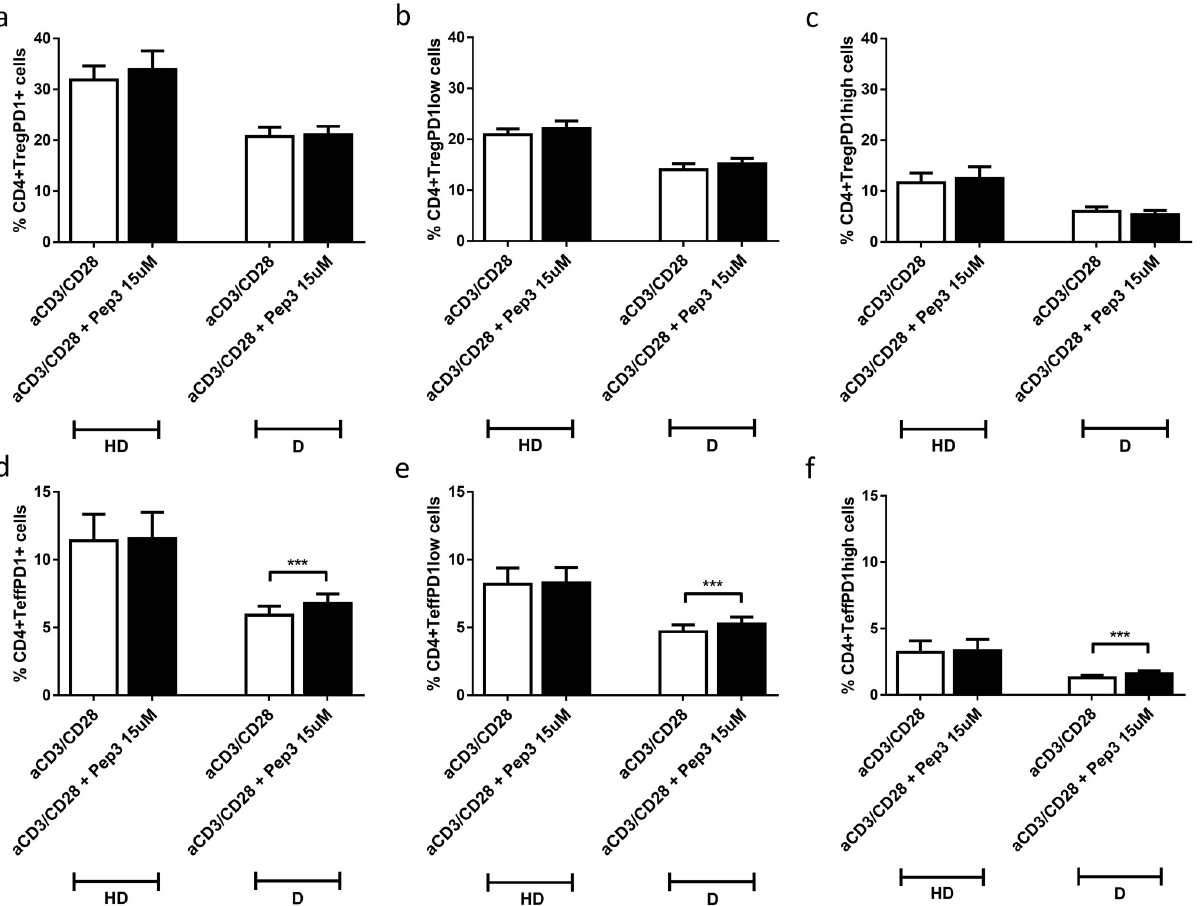
Fig 6. Frequency of CD4+PD1+ cell populations relative to HD and type 1 diabetes upon treatment with peptide 3 and subsequent stimulation with anti-CD3/CD28 beads for 4 days. Flow-cytometry analysis of HD and type 1 diabetes PBMC following 15 μ M of Pep3 treatment and subsequent stimulation for four days with anti-CD3/CD28 beads. Graphs show the percentage of CD4+ Treg PD1+ cells ( a ), CD4+ Treg PD1low cells ( b ), CD4+ Treg PD1high cells ( c ), CD4+ Teff PD-1+ cells ( d ), CD4+ Teff PD-1low cells ( e ), CD4+ Teff PD-1high cells ( f ). Percentages of PD1+, PD1low and PD1high cells were evaluated in comparison to the corresponding parental subset under evaluation. Values correspond to mean frequency ± SEM of 14 healthy controls (HD) and 16 long-term type 1 diabetes patients (D). ��� p < 0.001.